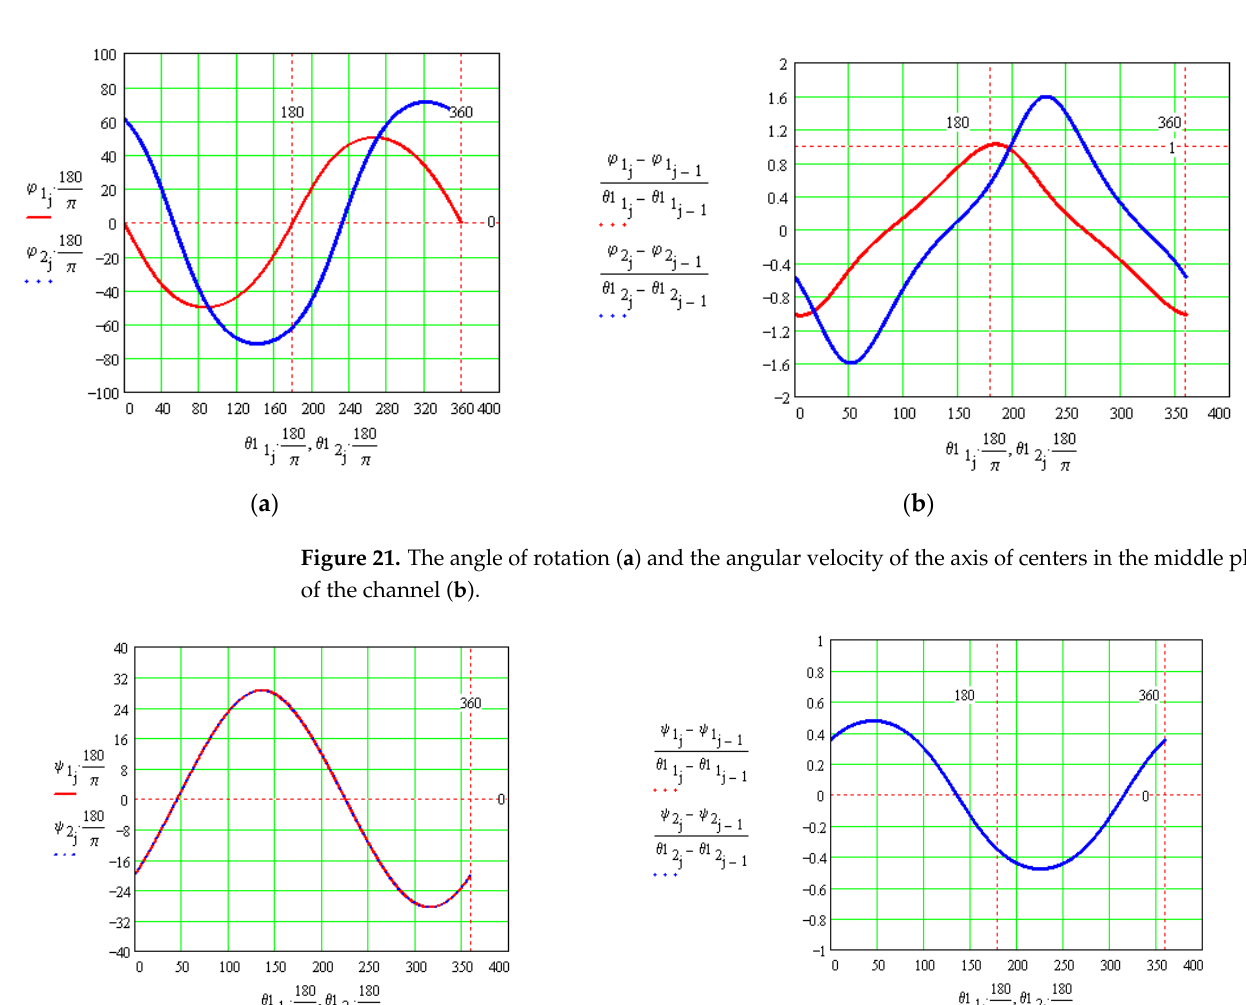
Figure 20. The path of the origins of the frame attached to the intermediate element in the median plane of the channel, for the two assembling possibilities.